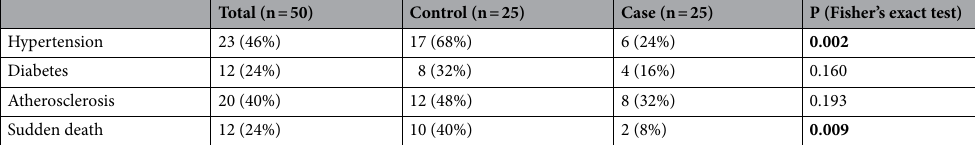
Table 3. Comparison of family history between control and case groups. Data are presented in numbers (%). Bold values imply statistical significance